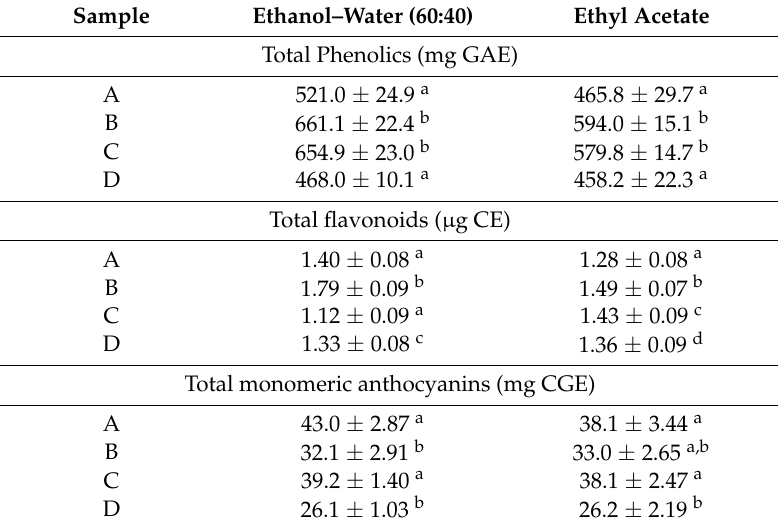
Table 1. Total phenolics, flavonoids and monomeric anthocyanins content in different lingonberry extracts. Sample